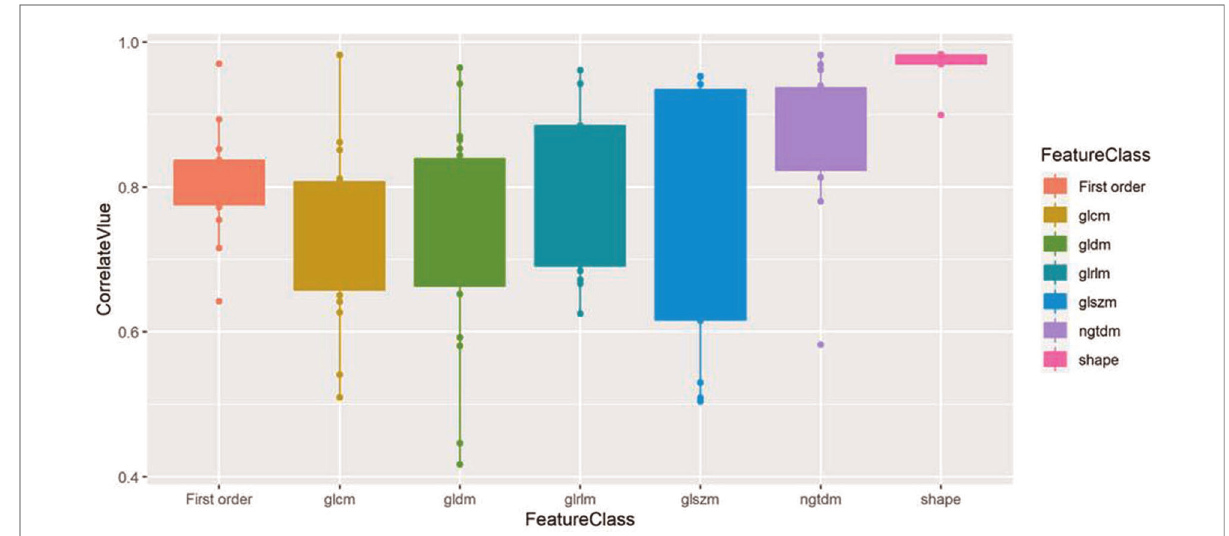
FIGURE 5 Box plot of the correlation value of various types of features between unenhanced and enhanced images. Shape features exhibit the highest